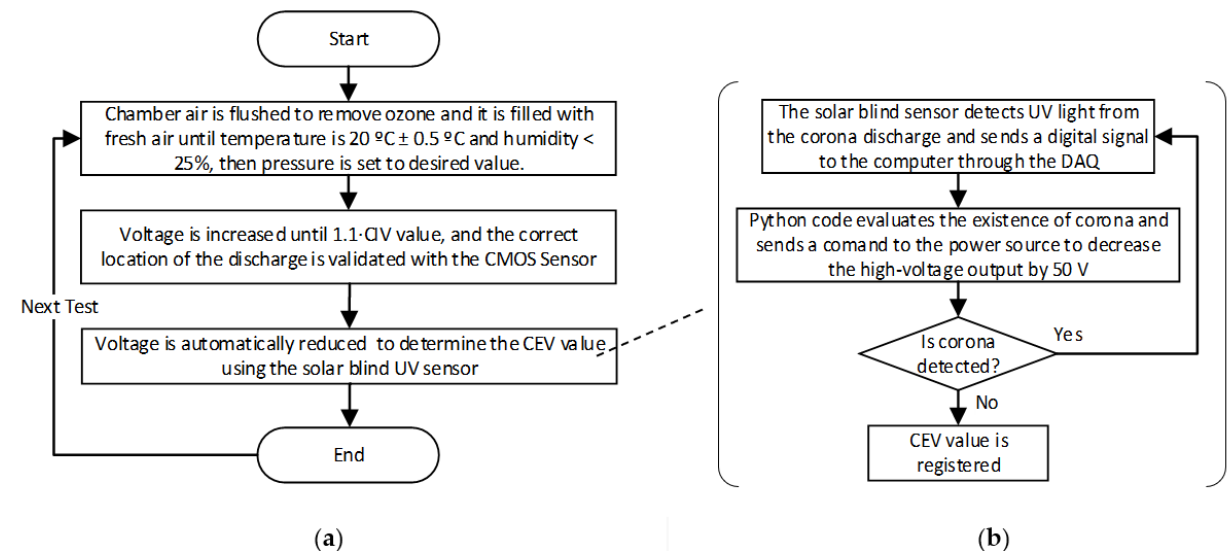
Figure 1. Procedure to determine the value of the CEV value of the sphere-to-plane air gaps. ( a ) Process overview. ( b ) Automatic acquisition of corona extinction voltage values using python pro- cess.